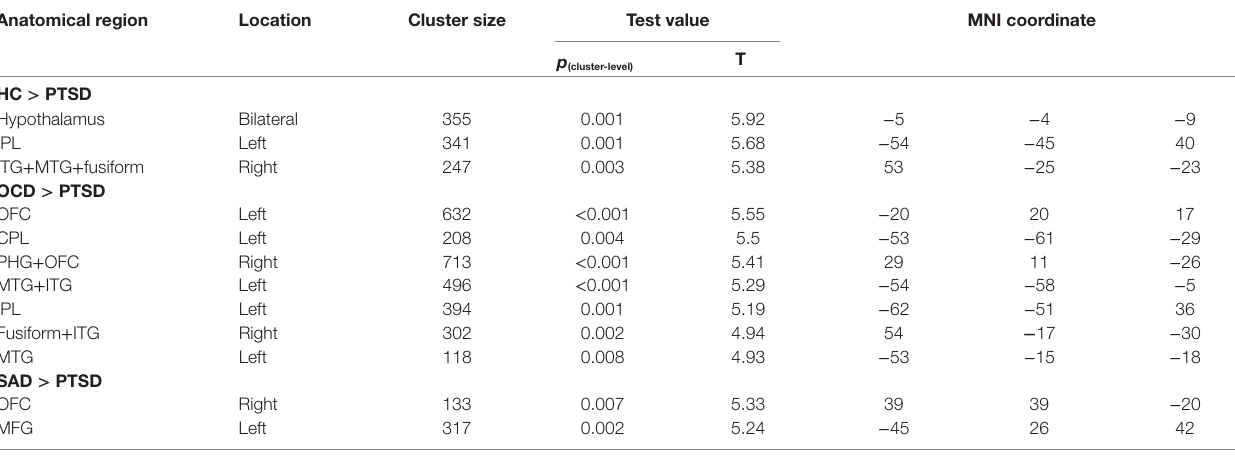
TaBle 3 | Post hoc whole-brain analysis of gMV differences between groups. anatomical region location cluster